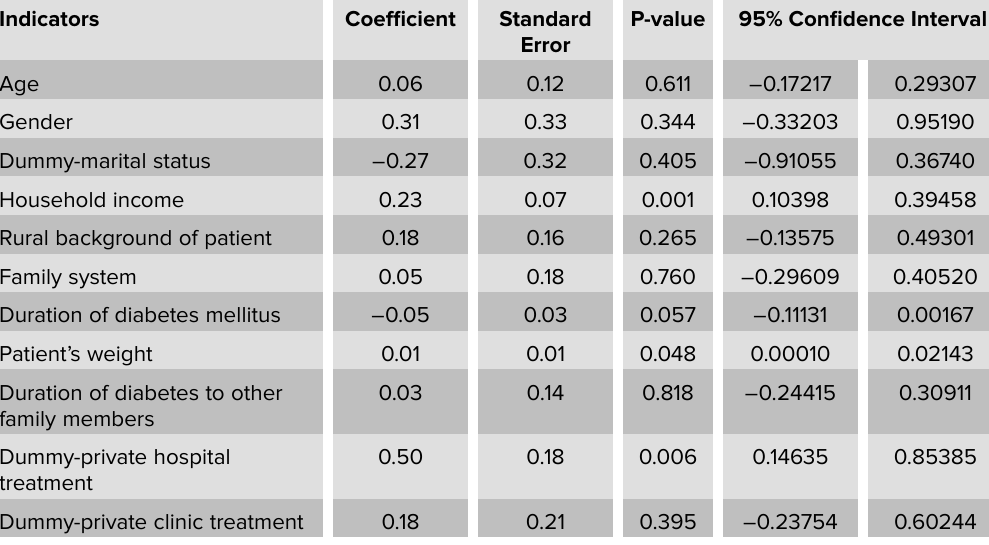
Table 2: Probability of self-care practices change due to demographic and medical factors [ N = 200] using [statistical